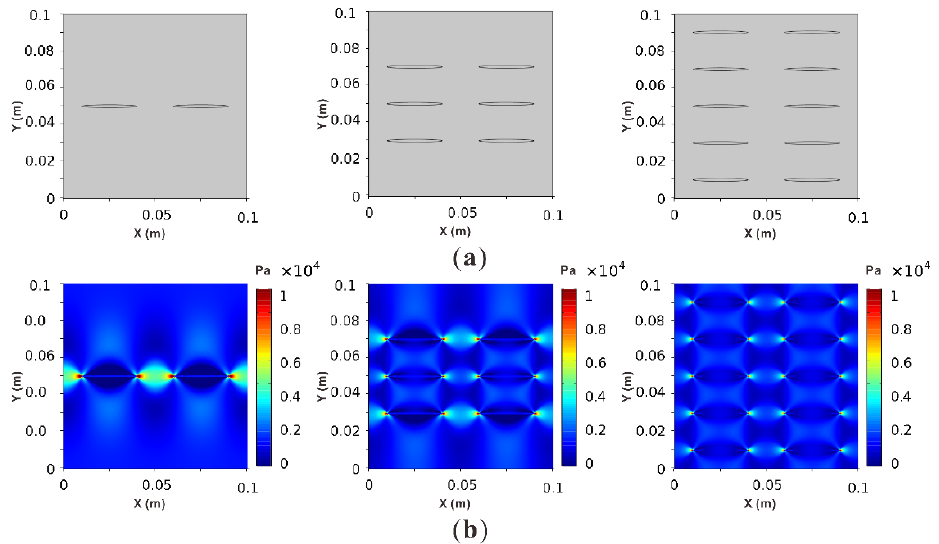
Figure 9. Stress distributions of 2D fractured models: ( a ) three 2D cracked models and ( b ) the stress ( σ xx ) distributions of the models. The stress dilution and concentration occur near the faces and tips (central parts) of fractures,